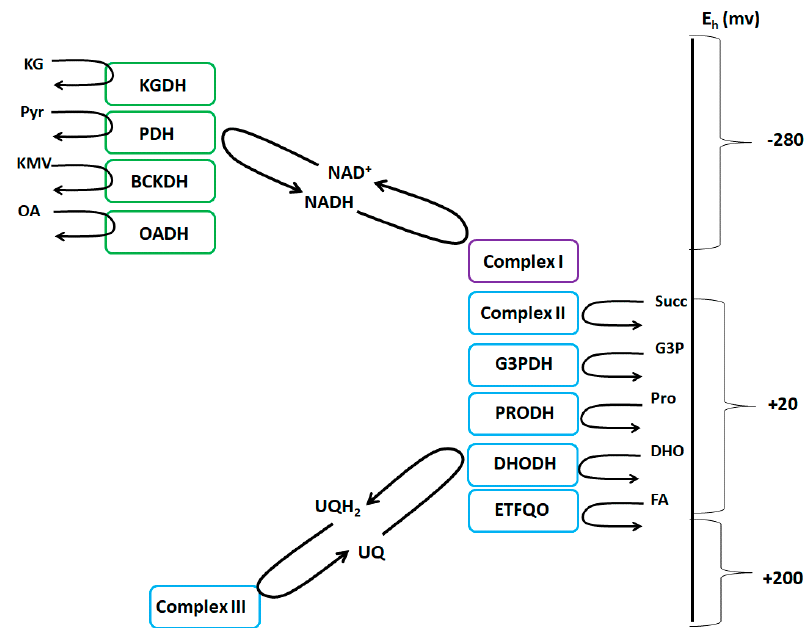
Figure 1. The NADH / NAD + and UQH 2 / UQ isopotential groups. The NADH / NAD + group (green) consists of KGDH ( α‐ ketoglutarate dehydrogenase), PDH (pyruvate dehydrogenase), BCKDH (branched ‐ chain keto acid dehydrogenase), OADH (2 ‐ oxoadipate dehydrogenase), and complex I. The UQH 2 /UQ isopotential group (blue) is made up of complex II, G3PDH ( sn ‐ glycerol ‐ 3 ‐ phosphate dehydrogenase), PRODH (proline dehydrogenase), DHODH (dihydroorotate dehydrogenase), ETFQO (electron transferring ‐ flavoprotein:ubiquinone oxidoreductase), and complex III. Complex I is denoted in purple since it uses both isopotential groups to form ROS and can produce ROS from both its flavin mononucleotide group and ubiquinone binding site, respectively.